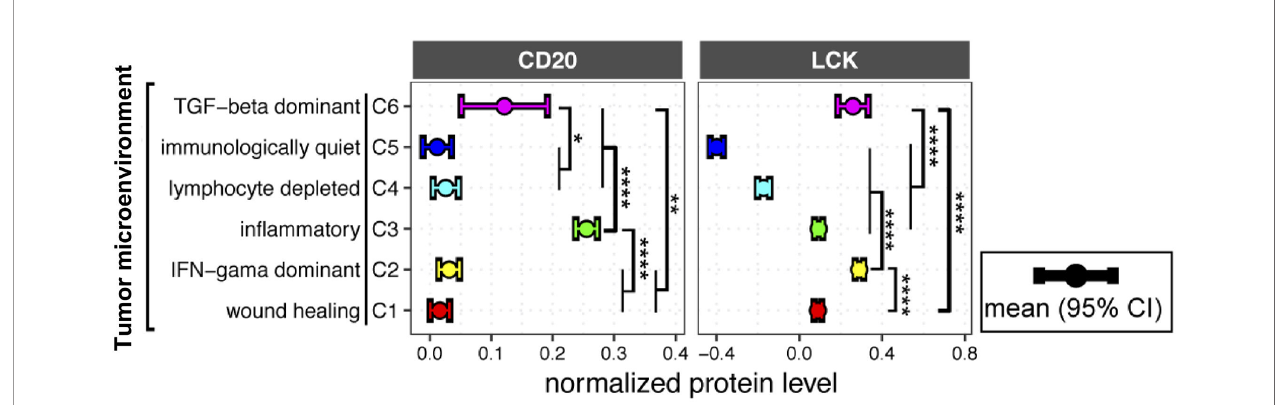
FIGURE 5 | LCK and CD20 protein levels across different tumor microenvironment (TME) subtypes. CD20 and LCK protein levels in different TME subtypes. The error bar represents the 95% con fi dence interval (CI), the dot represents the average value, with color coding according to cancer type. The p-value was calculated using the ANOVA test (* p -value<0.05, ** p -value<0.01, *** p -value<0.001, ****